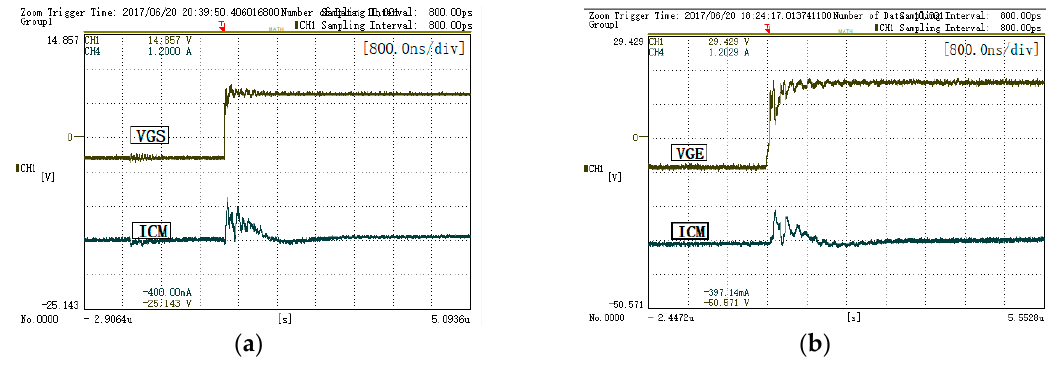
Figure 18. Turn-on common mode current. ( a ) GaN, ( b ) IGBT.